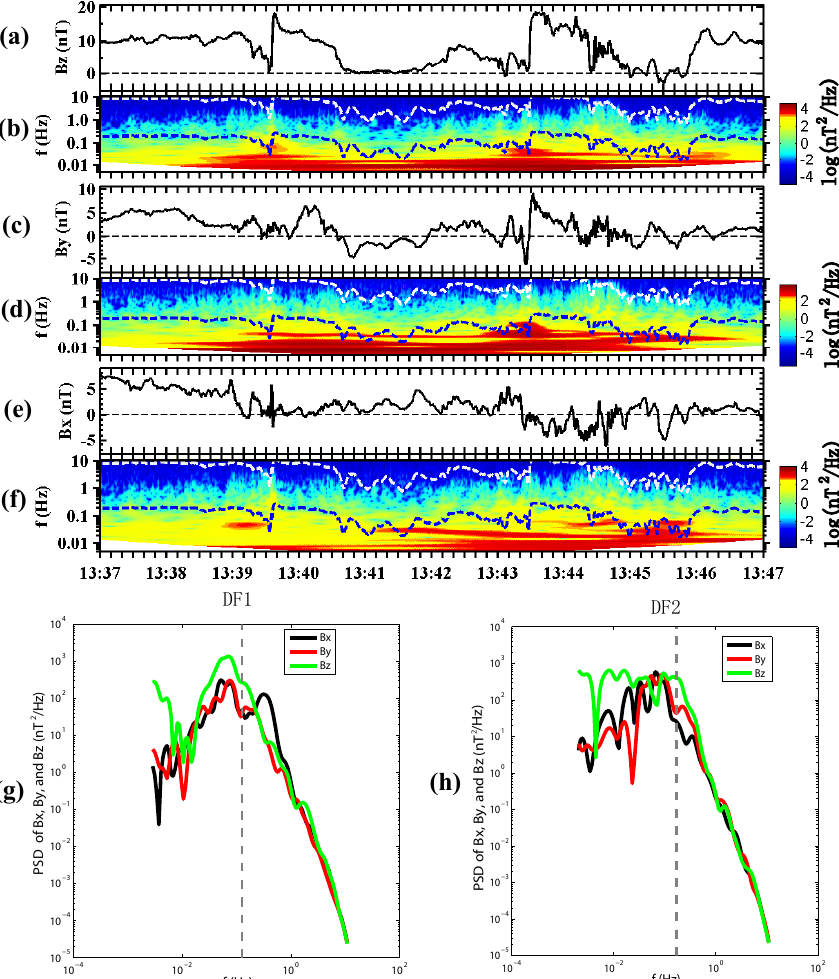
Fig. 5. Power spectrograms of magnetic fields recorded by Cluster-4. (a) , (c) , and (e) are three components of magnetic field B z , B y and B x , respectively. (b) , (d) , and (f) are power spectrogram of three components of magnetic field B z , B y and B x obtained via wavelet analysis. The blue and white traces show the Ion cyclotron frequency and lower hybrid frequency in each frequency-time spectrogram. (g) and (h) are the power spectrum densities (PSDs) around two DFs. The vertical dashed gray lines show the ion cyclotron